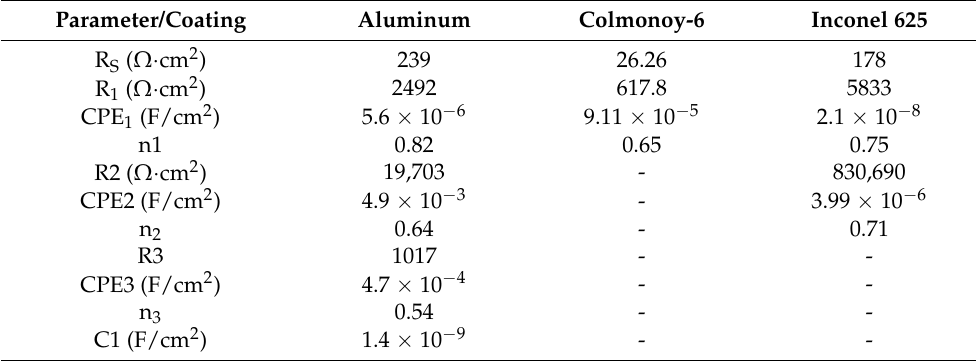
Table 5. Impedance parameters results calculated for all coatings at 50 ◦ C.